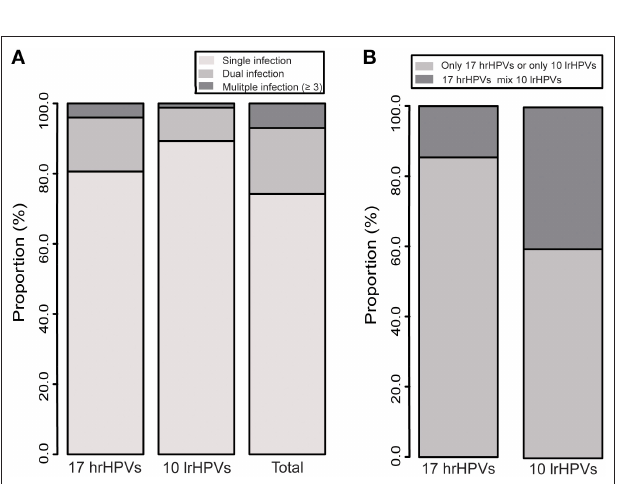
FIGURE 3 | (A) Distribution of multiple infections of 27 HPV genotypes. (B) Co-infection of 17 hrHPVs and 10 lrHPVs.